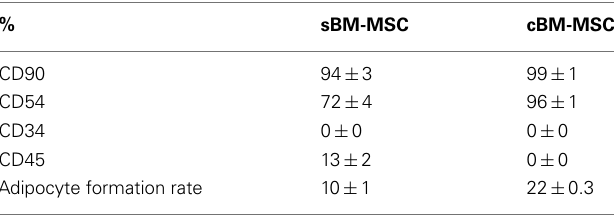
stem cells used in this study.